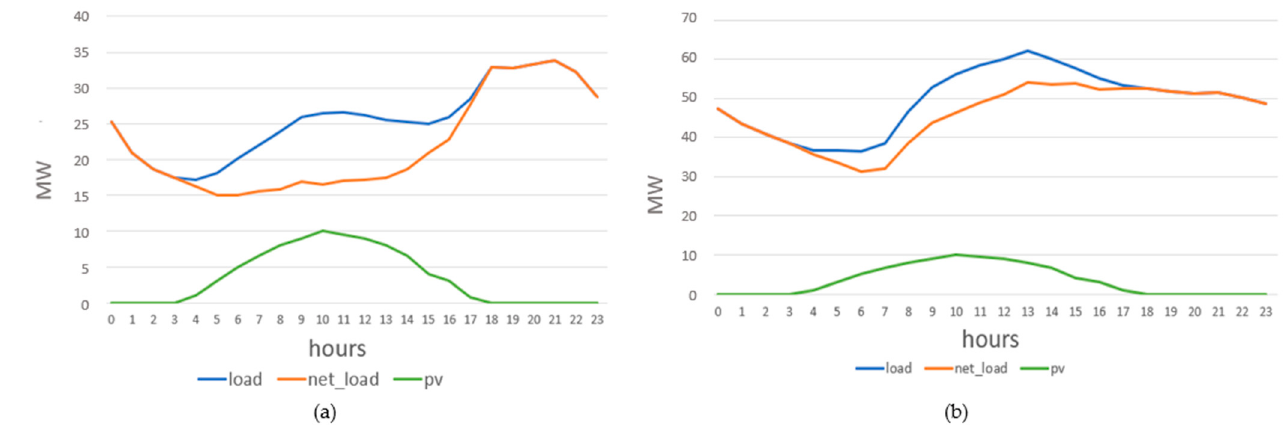
Figure 3. Load and PV profile with the net load for ( a ) case 1: day with minimum load, and ( b ) case 2: day with maximum load.